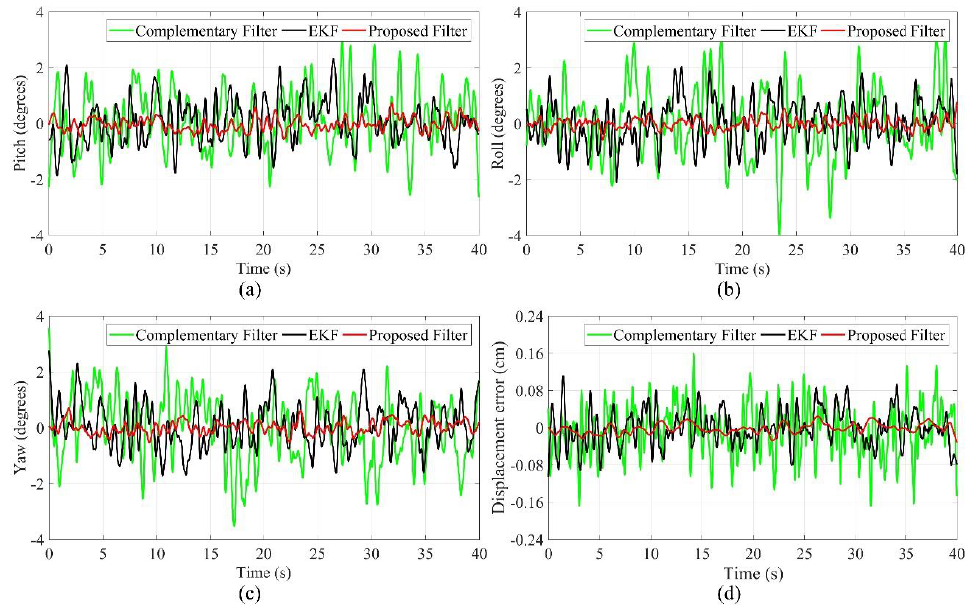
Figure 12. Drilling test at low speed ( a ) pitch angle; ( b ) roll angle; ( c ) yaw angle; ( d ) displacement error.